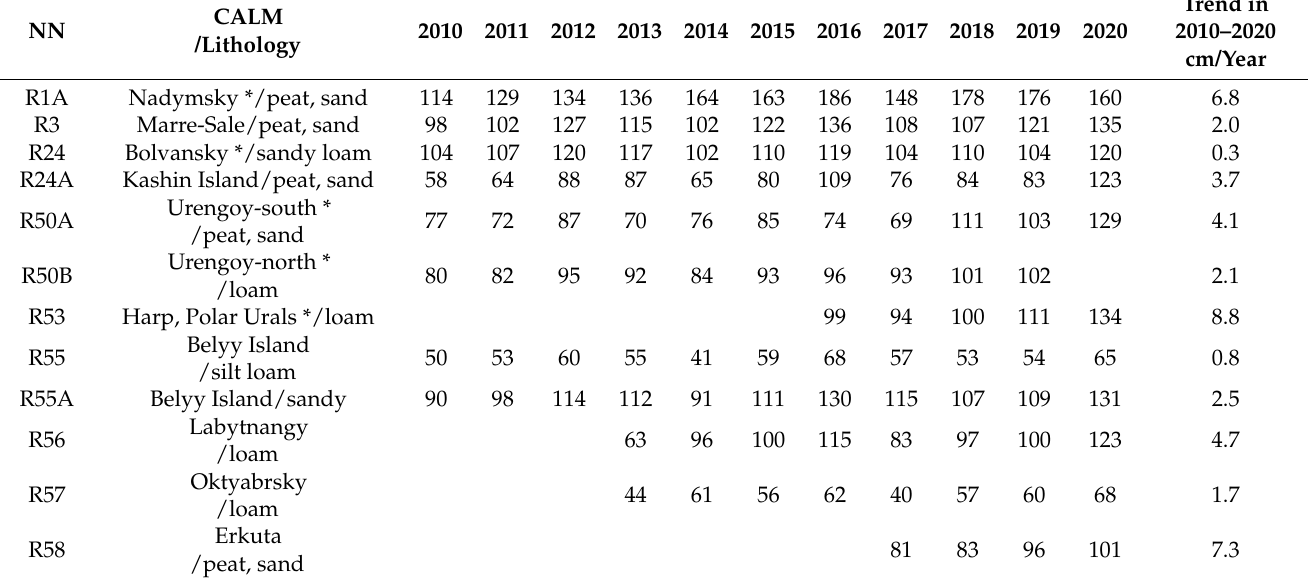
Table 3. Seasonal thawing depth values averaged for each site